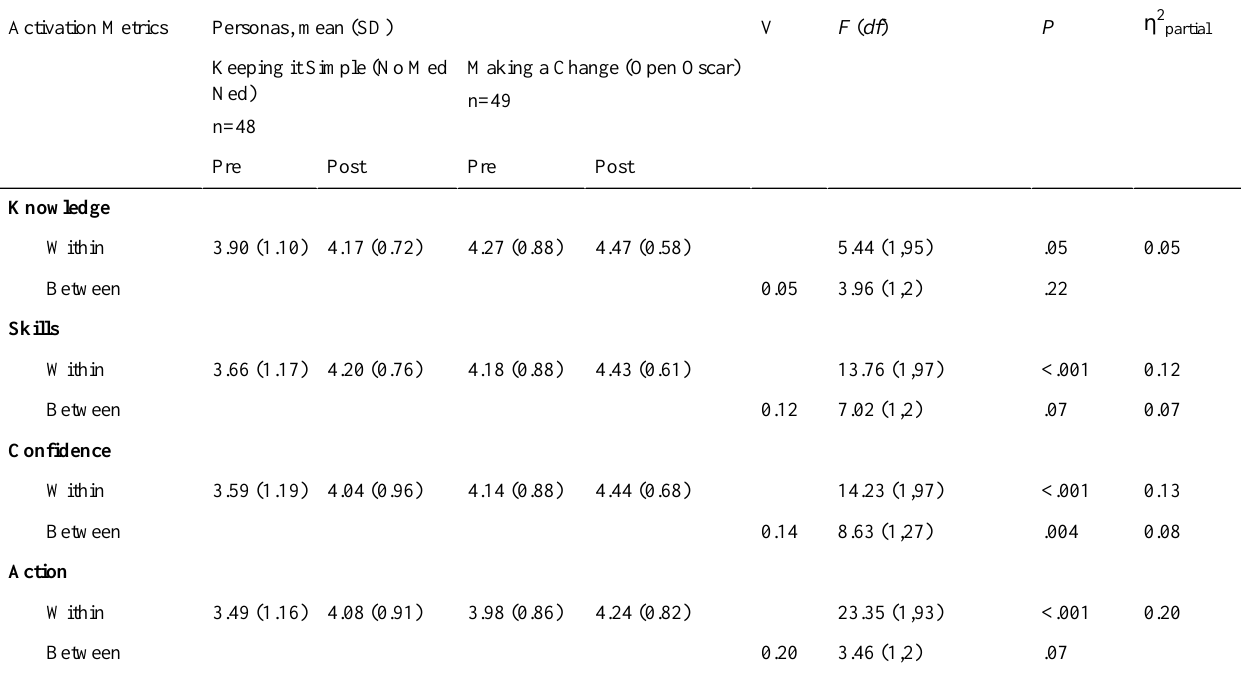
Table 6. Results of general linear model with repeated measures analyses of chronic health disease personas: type 2